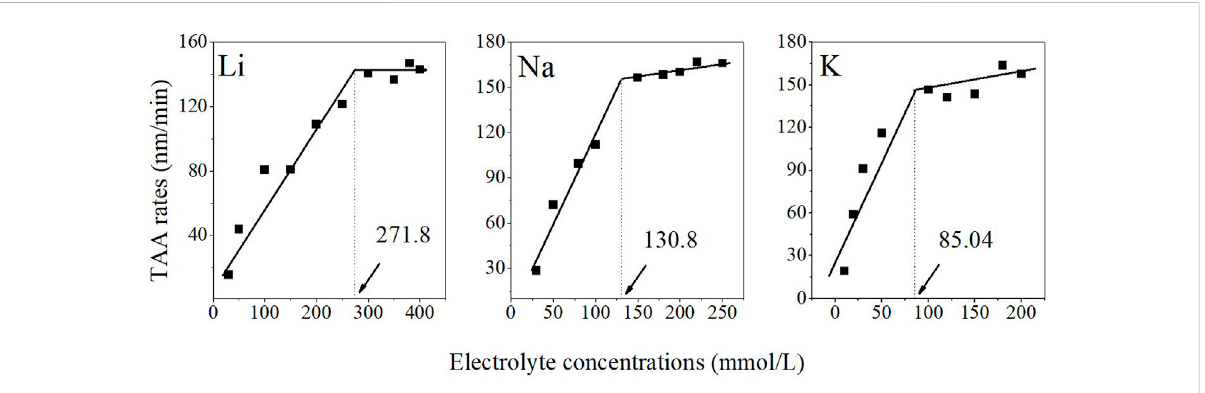
FIGURE 2 TAA rates for the aggregation of the montmorillonite particles as a function of the electrolyte concentration c 0 in LiNO 3 , NaNO 3 , and KNO 3 solutions. The turning points were CCC values in units of mmol/L.